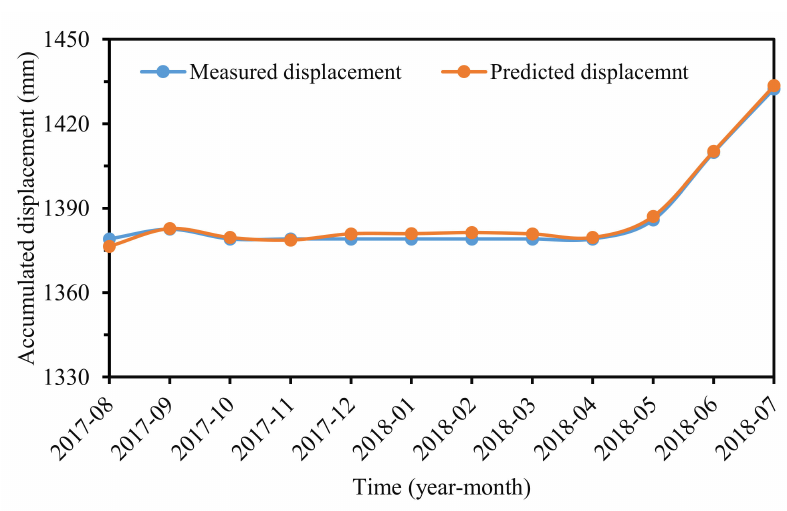
Figure 18. Predicted and measured accumulated